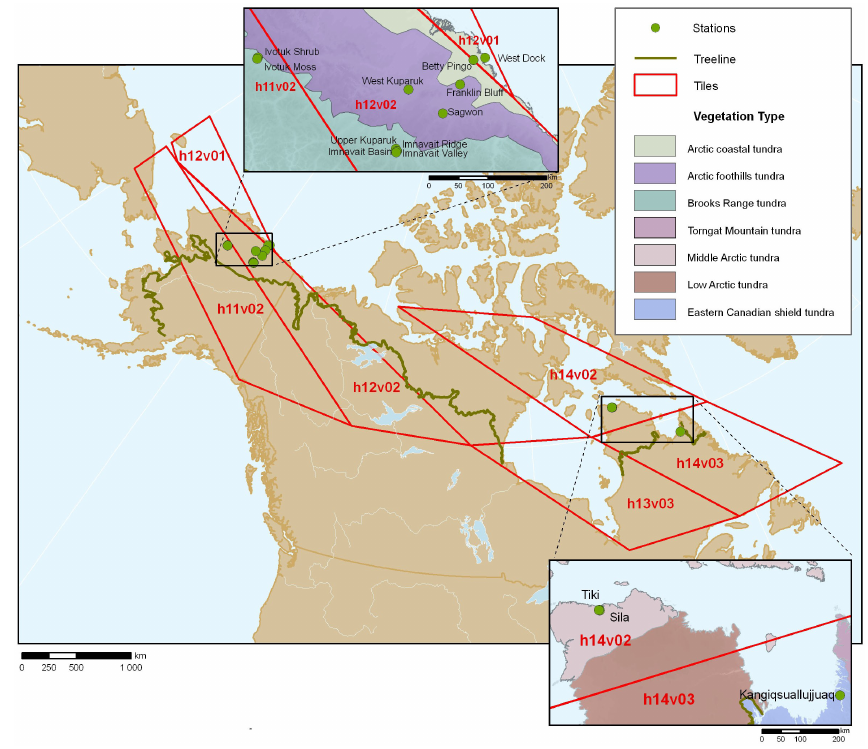
Fig. 1. Location of field sites and MODIS tiles for the North Slope of Alaska and Nunavik (Qu´ebec) in a Lambert conic conformal